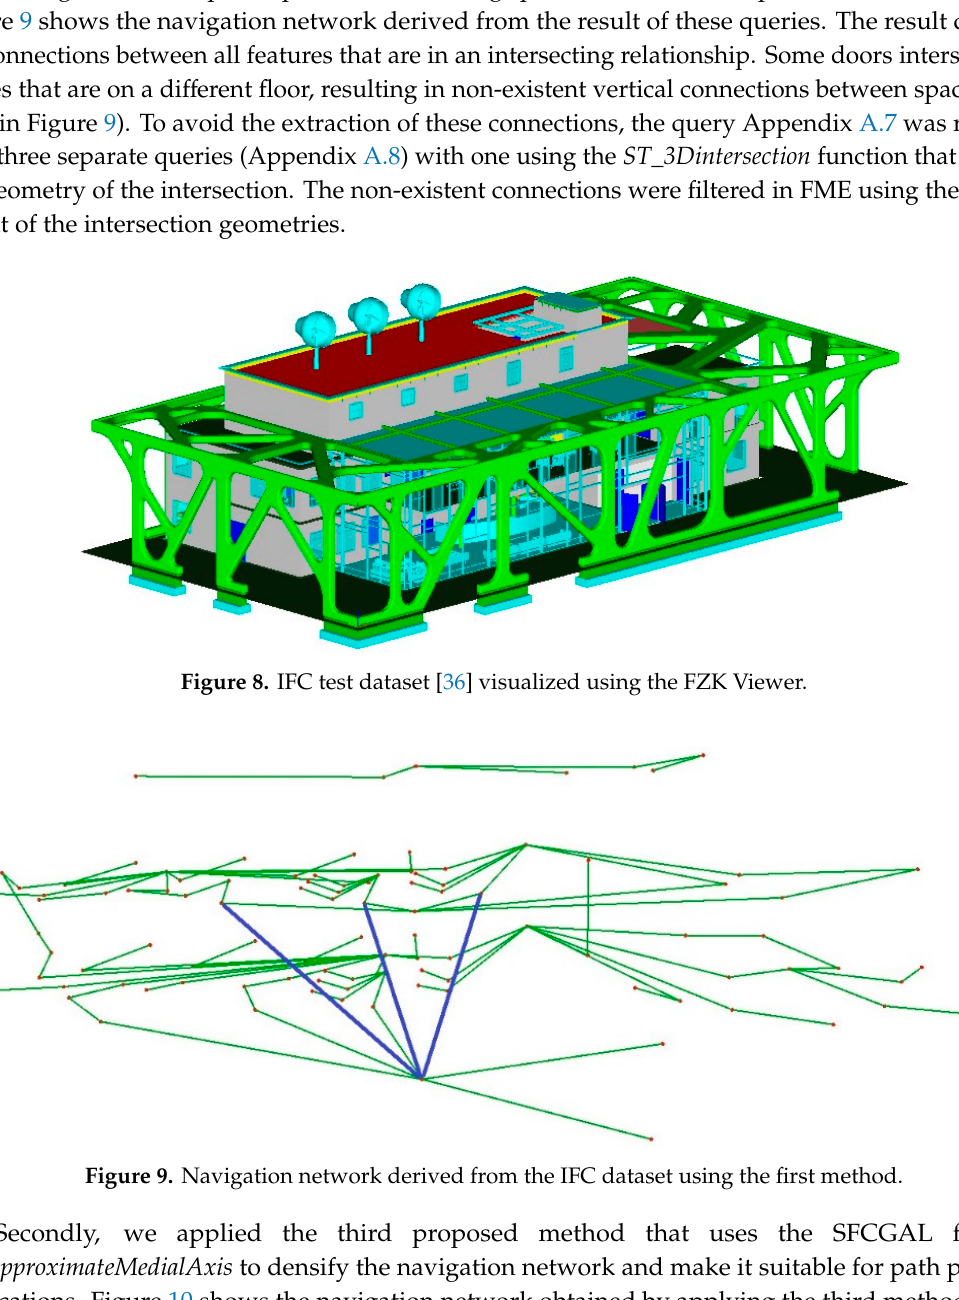
Table 2. Results of processing of the 3D cadastral datasets for the third method.